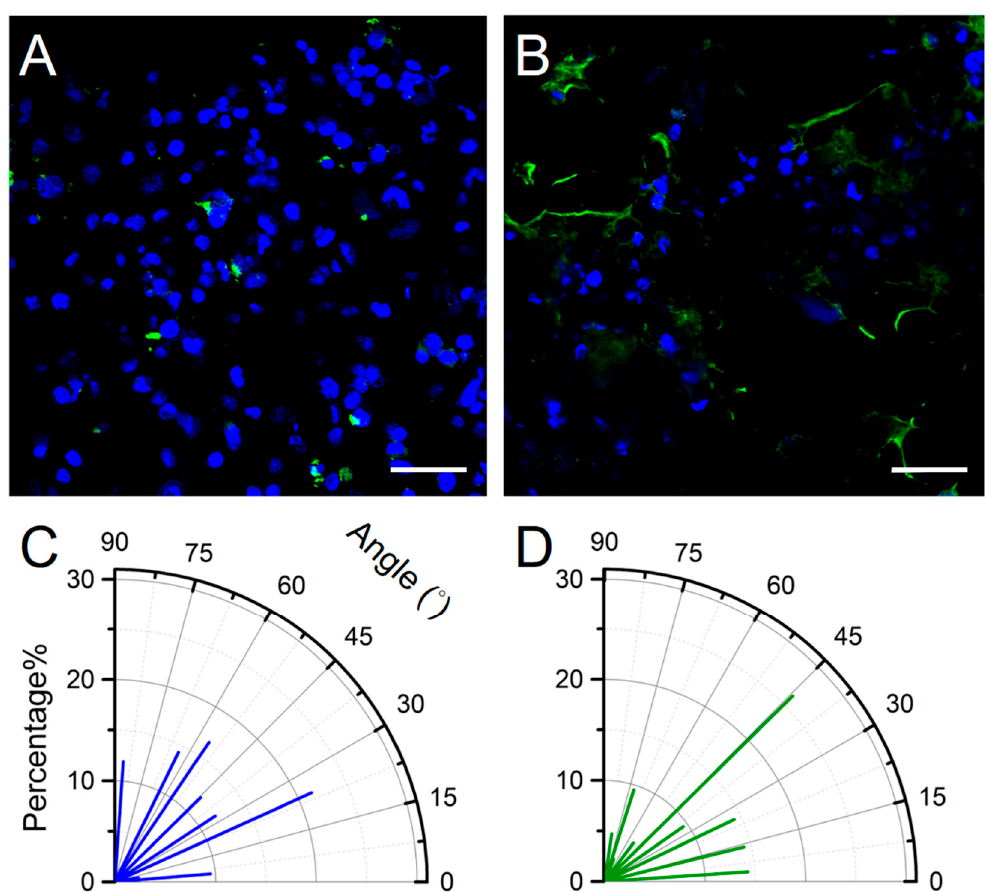
Figure 8. Cellular immunofluorescence staining and angle calculation. ( A ) no ZO-1 expression is visible in cells not exposed to shear stress, and ( B ) ZO-1 expression (green) is visible in cells under shear stress as documented using a confocal laser scanning microscope (DAPI: blue). Cell growth angles for cells under ( C ) no shear stress and ( D ) 5 dyne/cm 2 shear stress for one day ( n = 42).